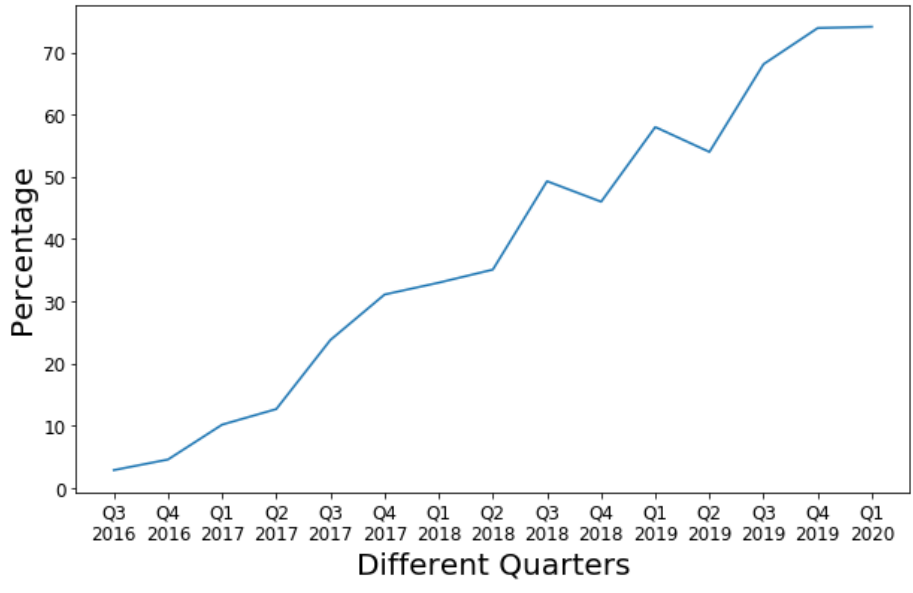
Figure 1. Percentage of phishing attacks hosted on